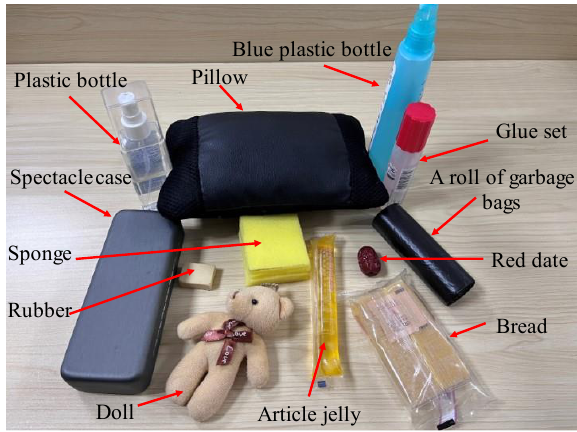
Figure 6. Twelve objects for experiments.